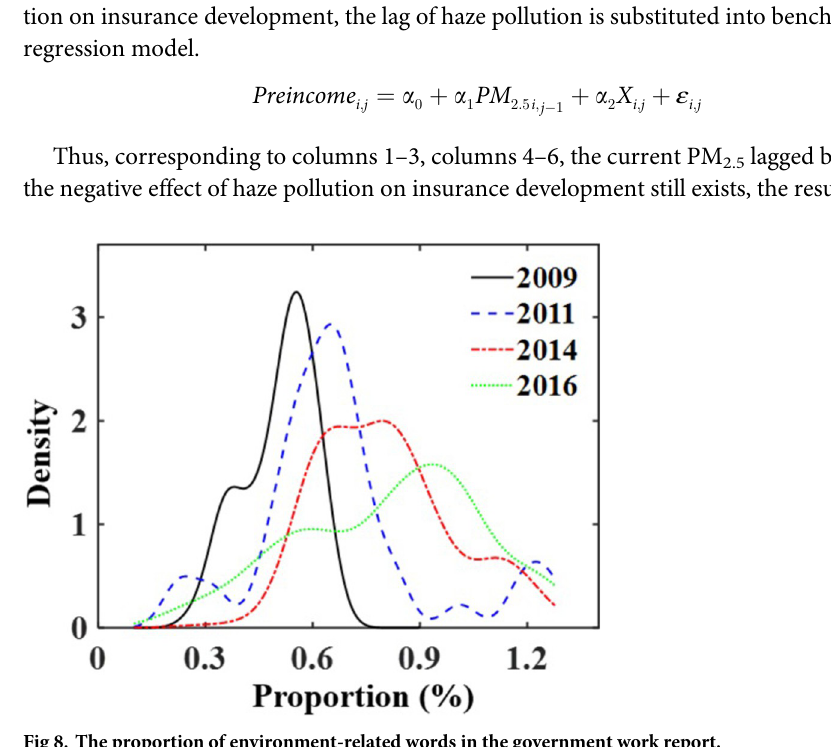
Fig 8. The proportion of environment-related words in the government work